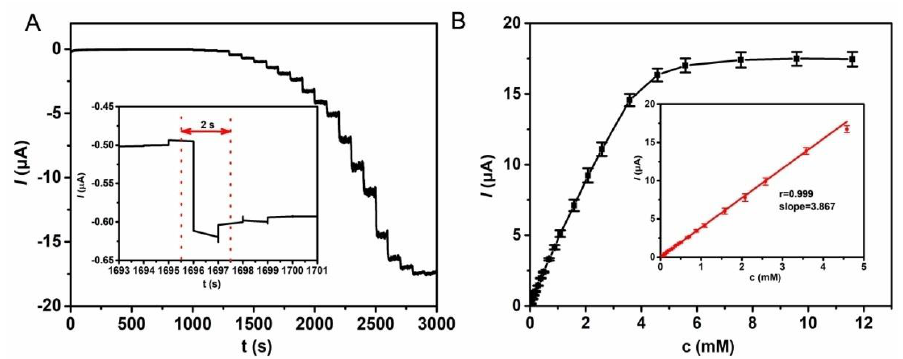
Figure 6. ( A ) Curve of steady-state response after injecting glucose into 10 mL of 0.1 M PB solution under fast stirring; Potential: 0.6 V. Inset A Partial magnification of Figure 6A. ( B ) Steady-state current-time response of the GOx/PS- b -P4VP/Pt by increasing glucose concentrations. Inset B : Calibration curve of steady-state current – time response.